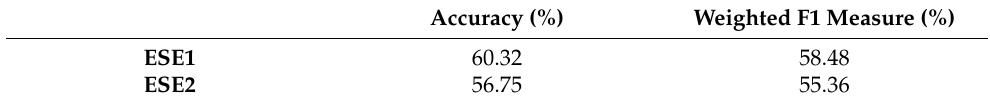
Table 6. Accuracy and weighted F1 measure for manual classification by two